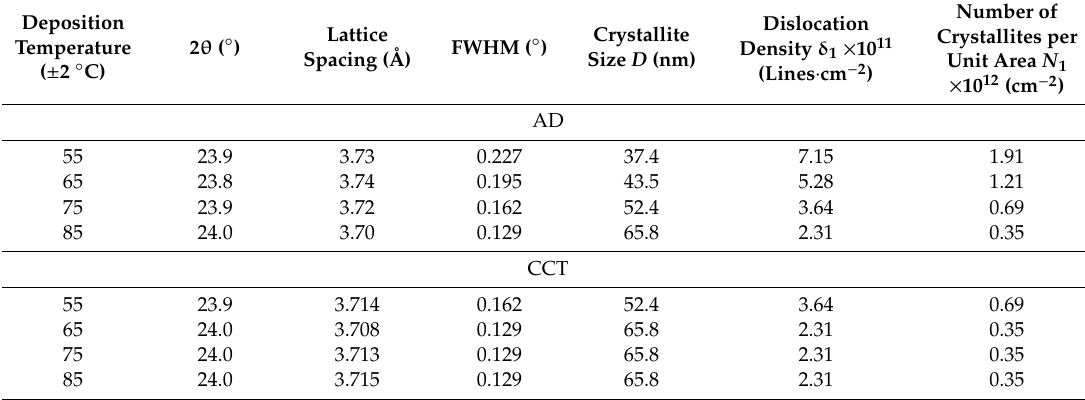
Table 1. Summary of the X-ray di ff raction analysis for cubic (111) CdTe di ff raction for AD and CCT-CdTe layers.